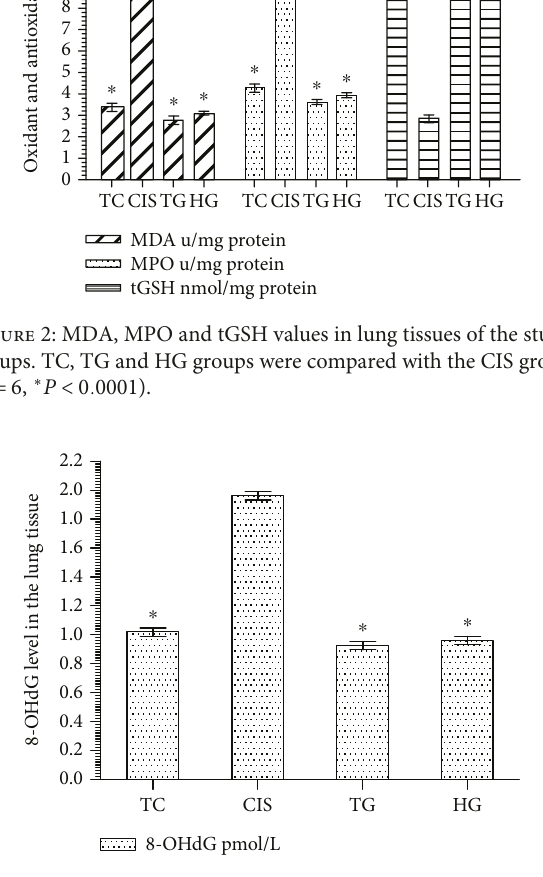
Figure 3: 8-OHdG level in lung tissues of the study groups.